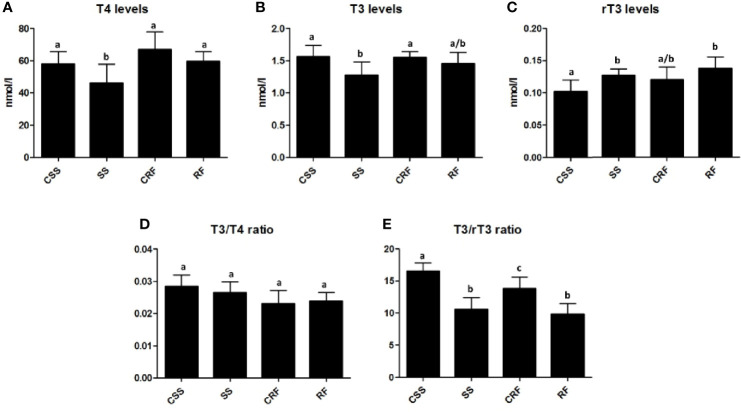
TH profile as represented by plasma levels of T4 (A), T3 (B), and rT3 (C) and resulting T3/T4 ratio (D) and T3/rT3 ratio (E) values. CSS: control of semi-starved rats; SS: semi-starved rats; CRF: control of refed rats; RF: refed rats. (A–E: n=4-8). Results are shown as mean values ± SD. Multiple comparisons between the groups were statistically evaluated by 1-way ANOVA followed by the Newman–Keuls test, or otherwise as indicated below. Bars labeled with dissimilar letters are significantly different; in A, SS vs. CSS and SS vs. RF, p<0.05; SS vs. CRF, p<0.001; in B, SS vs. CSS and SS vs. CRF, p<0.05; in C, RF vs. CSS, p<0.01; SS vs. CSS p<0.05, by Student’s t-test; in E, SS vs. CSS and RF vs. CSS, p<0.001; RF vs. CRF, p<0.01; SS vs. CRF and CRF vs. CSS, p<0.05.